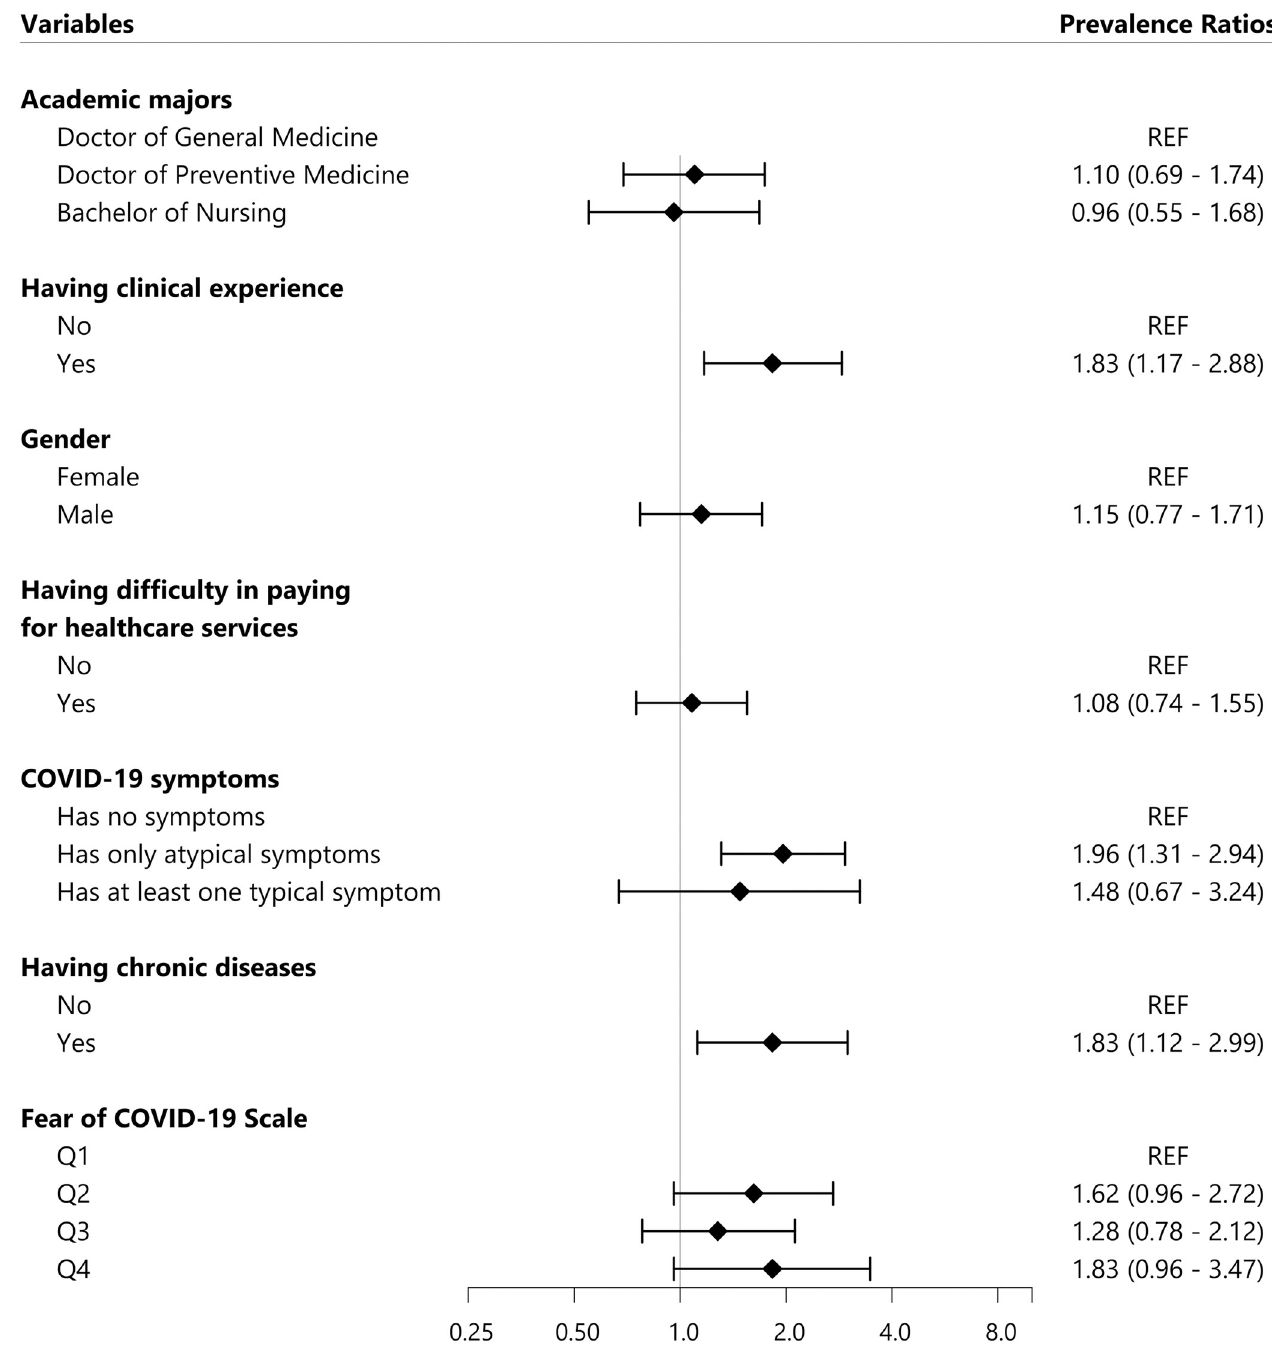
Fig 3. Factors associated with the worsening mental health status. All Prevalence Ratios were adjusted using Poisson multivariate regression model. REF: Reference value, COVID-19: Coronavirus Diseases of 2019, the FCoV-19S score was divided into four groups based on quartiles: Q1, Q2, Q3, and Q4. Q1 group contained 25% participants with the lowest score from 7 to 13 points; Q2 group consisted of 25% participants with medium low score from 14 to 20 points; Q3 group was 25% participants with medium high score from 21 to 27 points; Q4 group was 25% participants with highest score from 28 to 35 points.